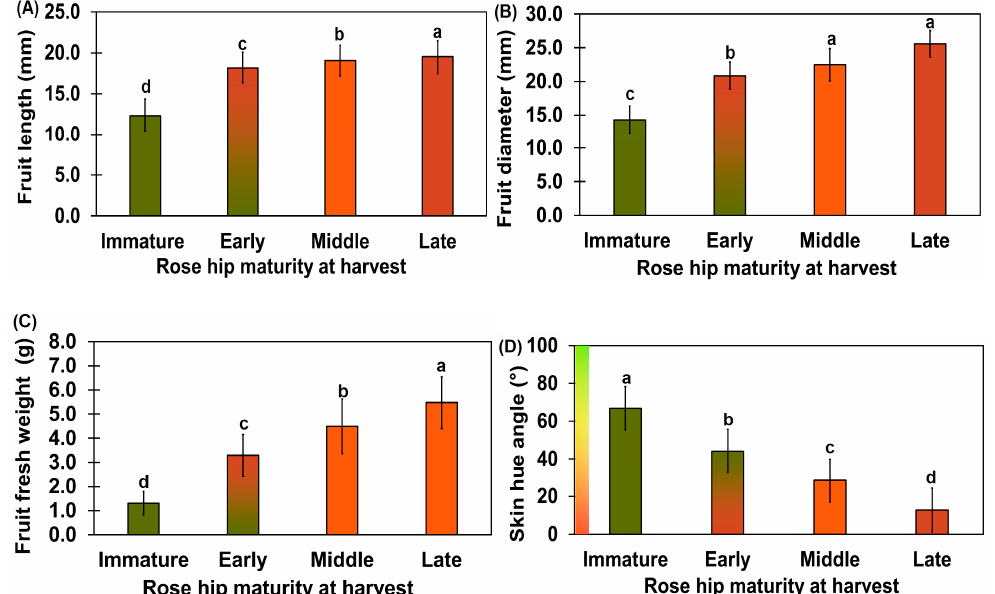
Figure 2. Diameter ( A ), length ( B ), weight ( C ), and surface hue angle ( D ) of rose hips at various ripening stages. The diameter of the rose hip flesh was measured using digimatic calipers at the widest cross-section point ( A ). The length of the rose hip flesh was measured using digimatic calipers at the widest part of the longitudinal section ( B ). The weight of the rose hip flesh was measured using an electronic scale ( C ). The hue angle was determined by converting the RGB values using the OI Color Picker program (https://shaeod.tistory.com/565, accessed on 11 February 2021) and SAL 1650 camera photos ( D ). Different letters above the error bars indicate significant differences according to Tukey’s HSD test ( p < 0.05). Number of immature rose hip samples = 14; number of early-, mid-, and late-stage rose hip samples =